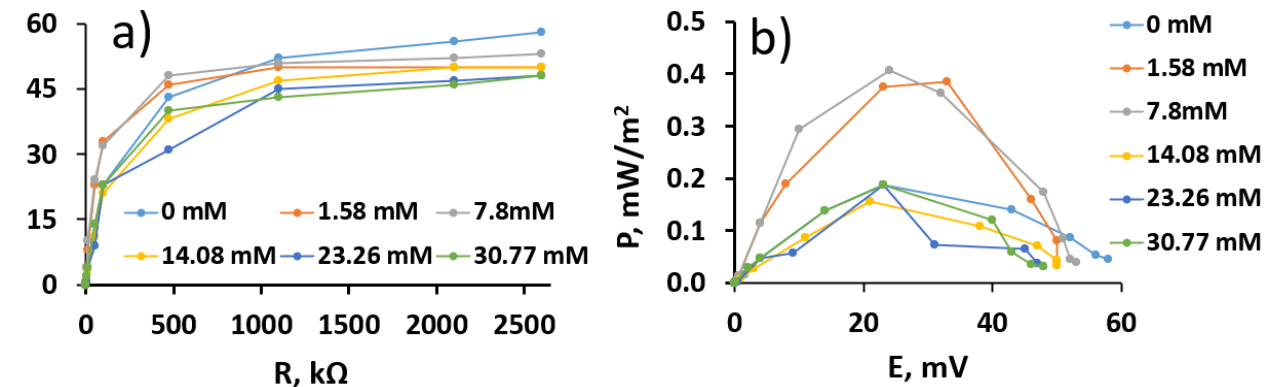
Figure 7. ( a ) Potential dependence on applied load; ( b ) calculated power density dependence on the generated potential in a single-compartment-based Microbial fuel cell (MFC), which consisted of an MD- and yeast-modified anode and a bare graphite cathode immersed in the phosphate–acetate buffer solution containing 23 mM of potassium ferricyanide and variable concentrations of glucose: 0 mM, 1.58 mM, 7.8 mM, 14.08 mM, 23.26 mM, and 30.77 mM.